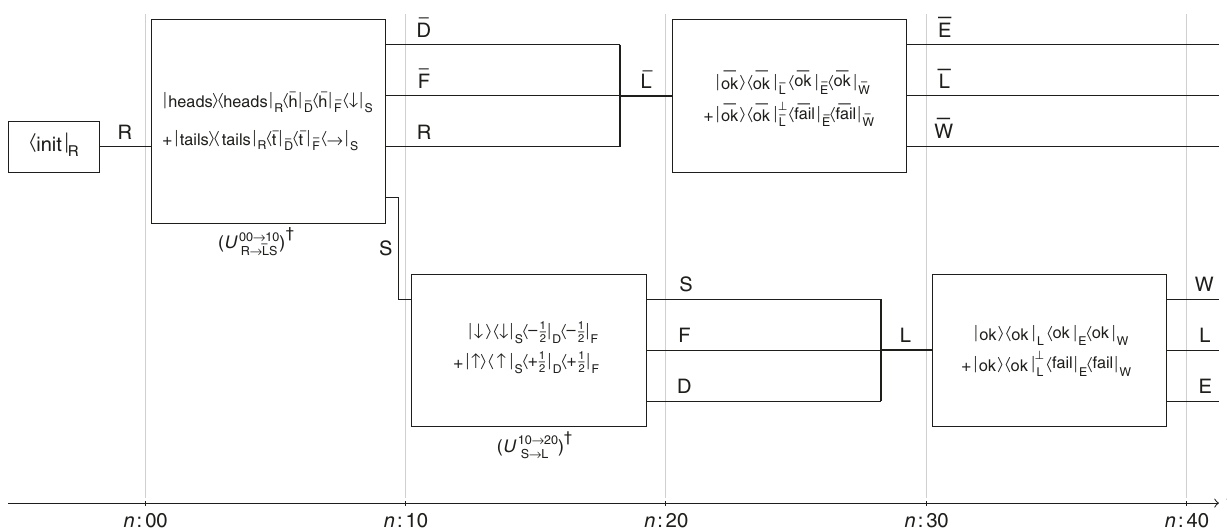
Fig. 4 Circuit diagram representation of the Gedankenexperiment. The actions of the agents during the protocol correspond to isometries (boxes) that act on particular subsystems (wires). For example, the measurement of S by agent F in the second protocol step, which starts at time n :10, induces an isometry U 10 ! 20 ’ s lab L, analogous to the one de fi ned by (2). The subsystems labelled by F , F, W , and W contain the agents themselves. Similarly, D , D , E , S ! L from S to F and E are “ environment ” subsystems, which include the agents ’ measurement devices. The states of these subsystems depend on the measurement (cid:1) (cid:1) outcome, which is indicated by their label. For example, þ 1 2